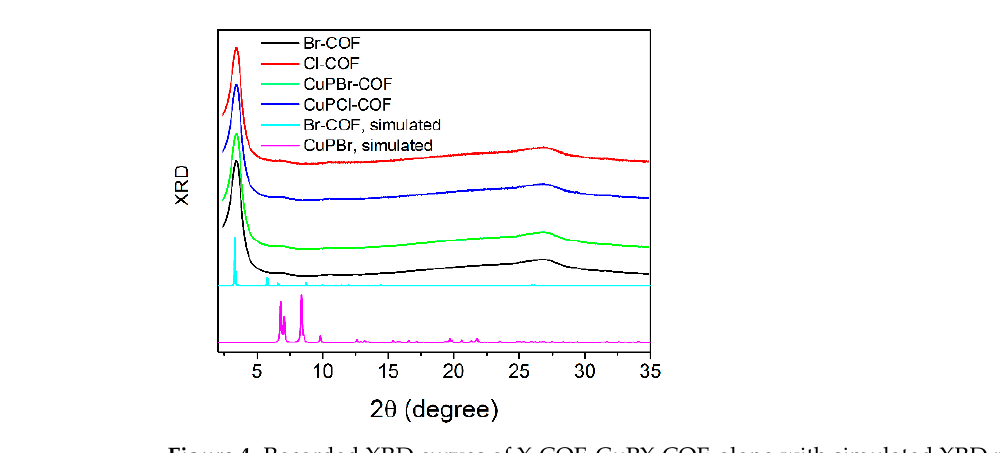
Figure 5. SEM mages of CuPBr-COF ( a ), CuPCl-COF ( b ) and Br-COF ( c ), and elemental mapping of CuPBr-COF (( d ), SEM, ( e ), C, ( f ), N, ( g ), Cu).